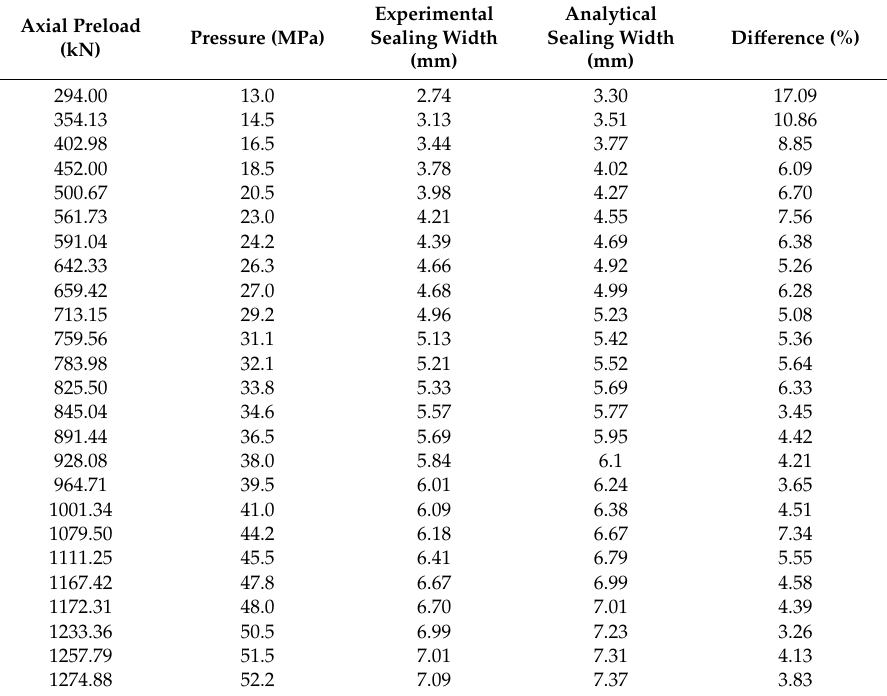
Table 2. Comparison of the sealing width of the experimental and analytical results.